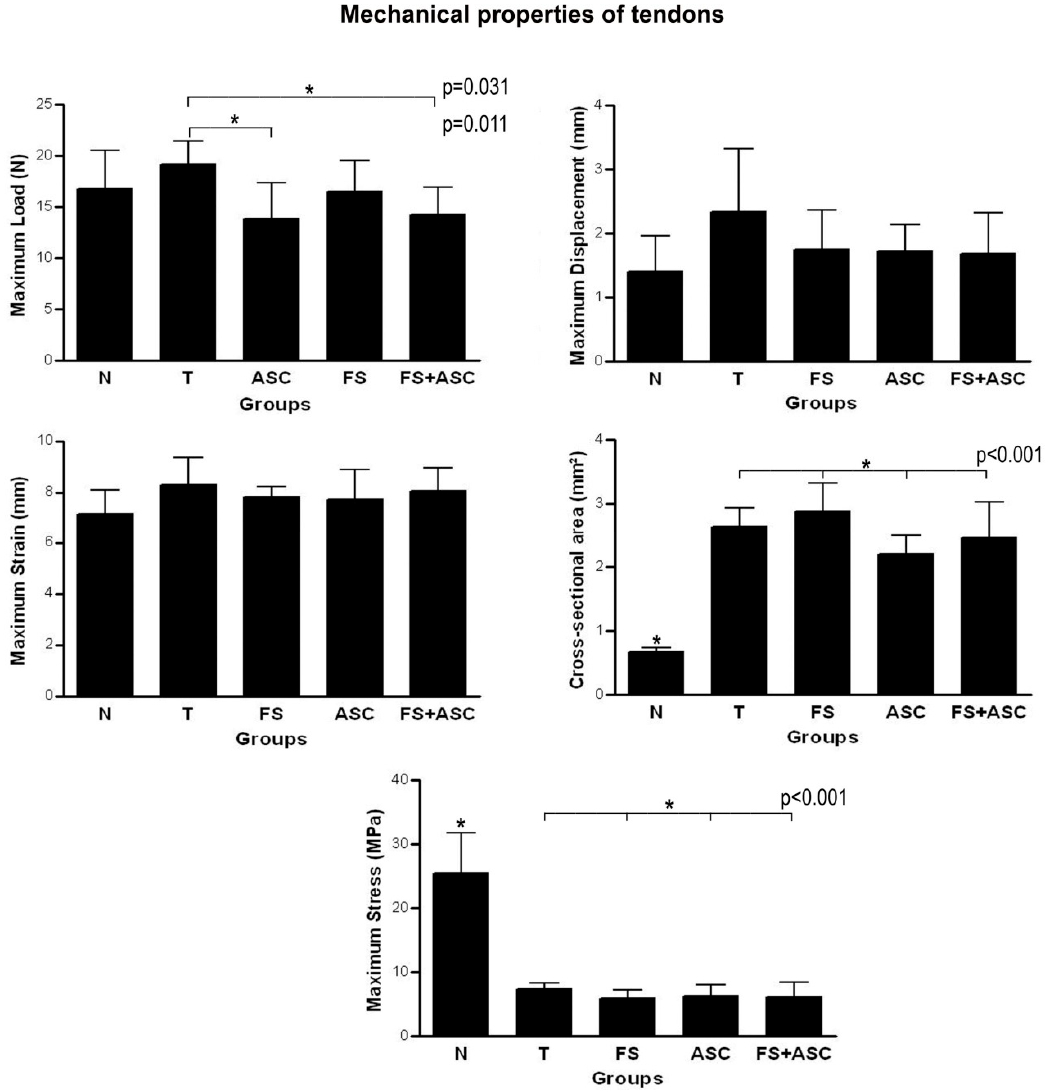
Figure 9. Mechanical properties of transected tendons from groups T, FS, ASC and FS + ASC ( n = 8). (*) Significant difference between the groups.